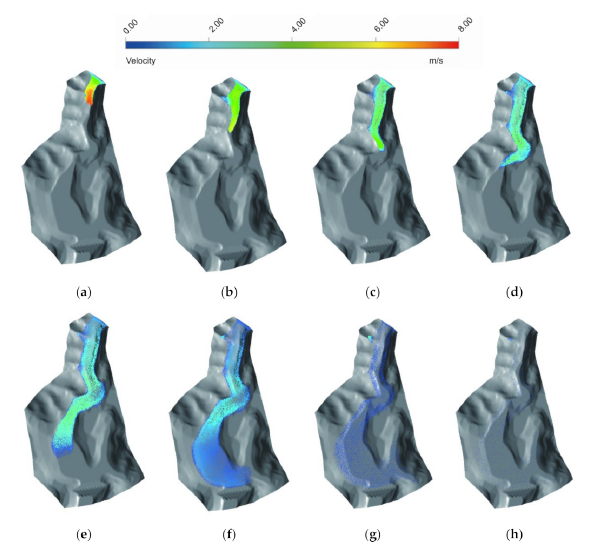
Figure 6. Velocity variations at different times for the process of the Dagangding tailings flow: ( a ) t = 10 s; ( b ) t = 20 s; ( c ) t = 40 s; ( d ) t = 80 s; ( e ) t = 160 s; ( f ) t = 320 s; ( g ) t = 640 s; ( h ) t = 1280 s.